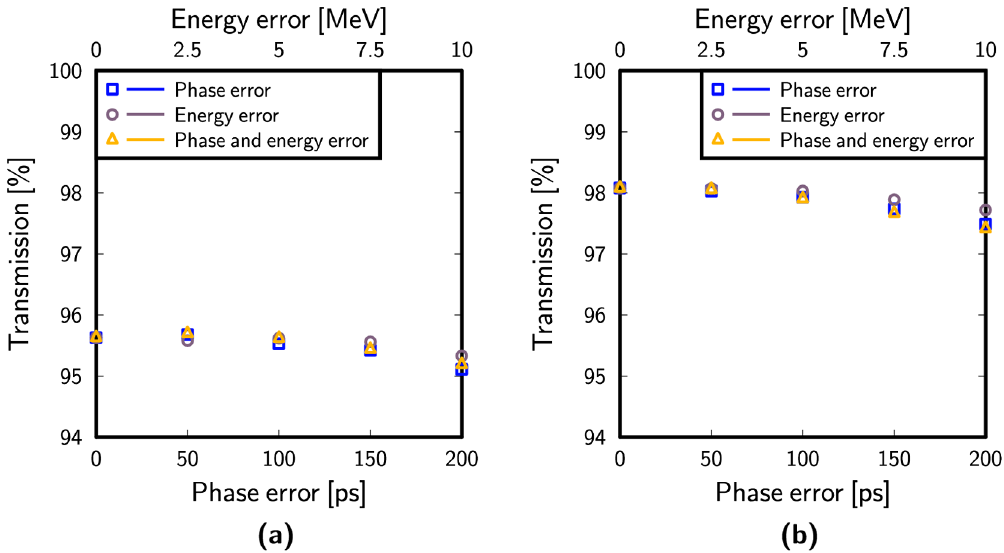
FIG. 7. Phase and/or energy errors: (a) under operational conditions; (b) using rotation voltages of V 40 MHz ¼ 600 kV and V 80 MHz ¼ 600 kV with optimal rotation